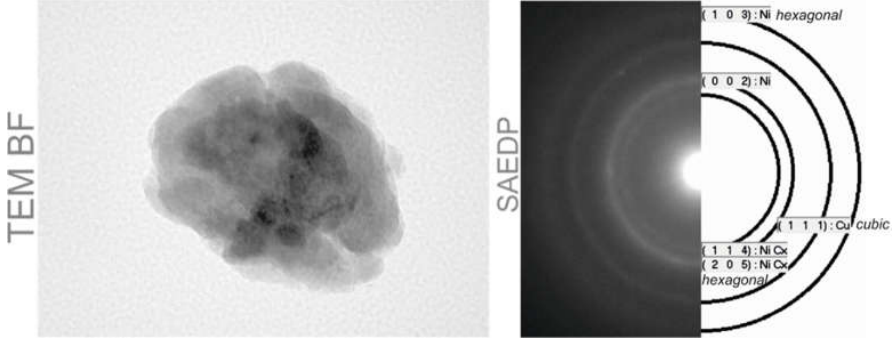
Figure 5. Image of the grain component CuXX performed in spectroscopy TEM method and diffraction image of the grain with assigned